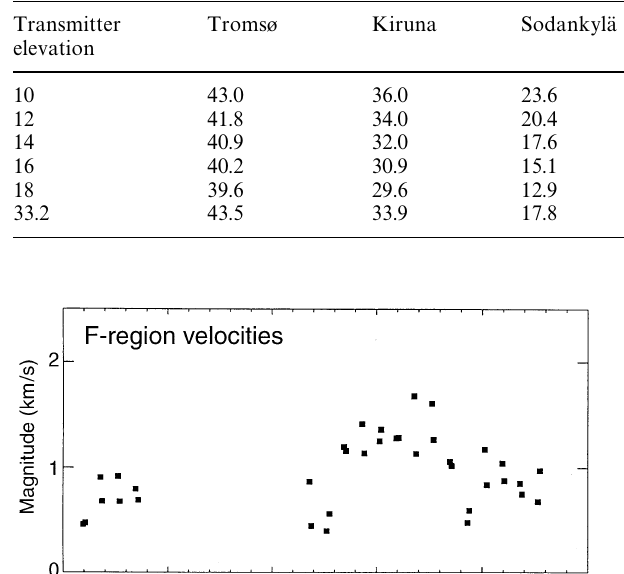
Table 3. Radar LOS bearing at target (degrees E of N)